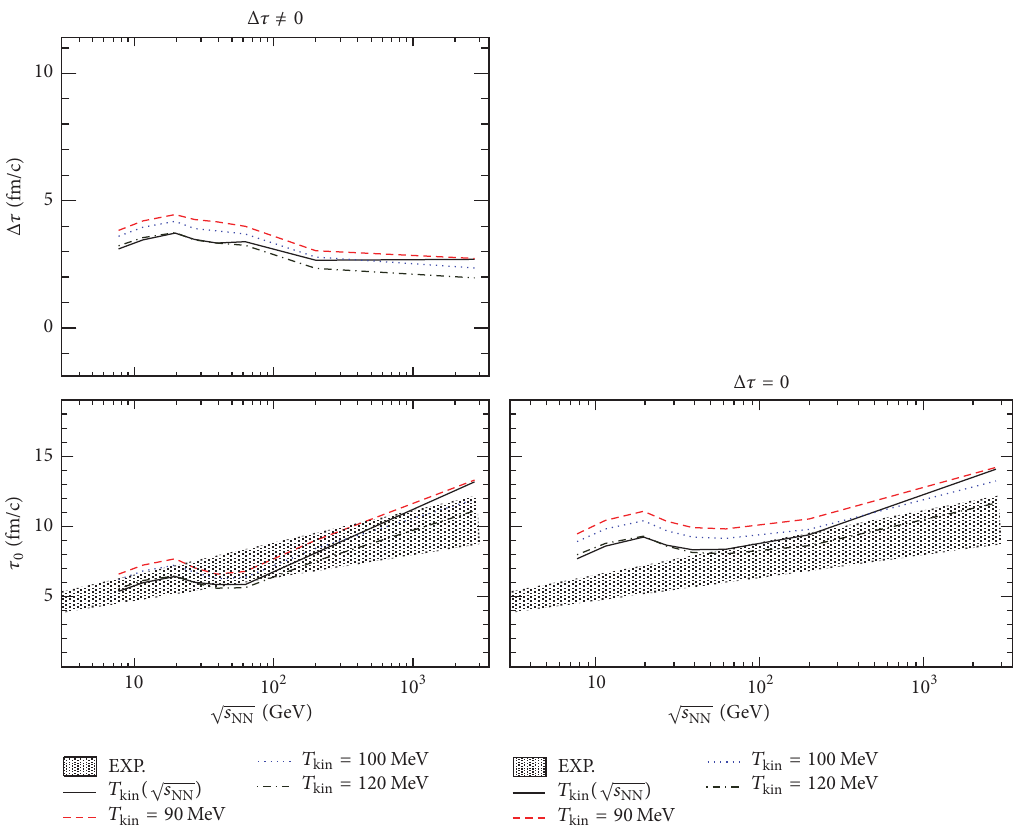
Figure 6: The same as Figure 4 but for 𝜏 0 and Δ𝜏 . Experimental data (shadowed area) is taken from [20].